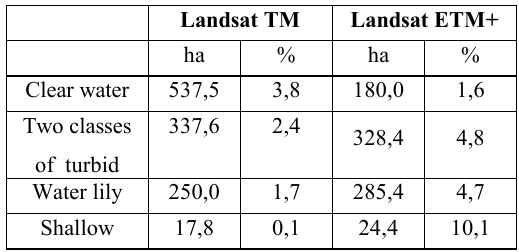
Table 1. Results of classification Landsat data of Lake Aba Samuel in 1986 and